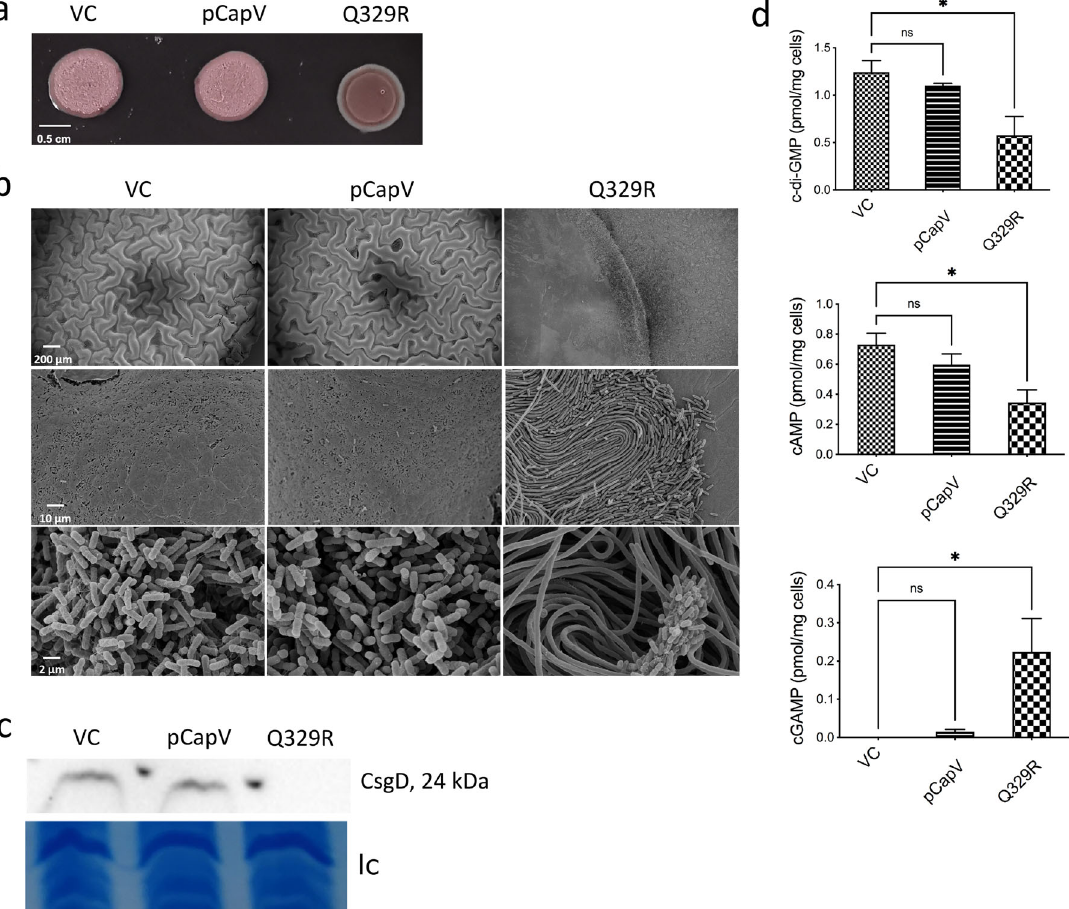
Fig. 8 CapV Q329R expression modulates rdar bio fi lm formation, CsgD expression, and cyclic (di)nucleotides levels in E. coli strain No. 12. a Rdar morphotype in wild-type E. coli No. 12 vector control (VC) and upon overexpression of CapV and its mutant CapV Q329R . Cells were grown on a salt-free LB agar plate for 24 h at 37 °C. b Scanning electron microscopy of plate-grown colonies. Colony morphotypes grown on a salt-free LB agar plate were fi xed after 24 h of growth at 37 °C. c CsgD production upon overexpression of CapV and CapV Q329R in E. coli strain No. 12 compared to VC. Only colony morphotypes from the same plate and signals from the same western blot are compared. d LC-MS/MS quanti fi cation of in vivo amounts of c-di-GMP, cAMP, and cAMP-GMP upon overexpression of CapV and CapV Q329R in E. coli strain No. 12 compared to VC. Data are displayed as absolute amounts referred to the original cell suspension. VC = pBAD28. pCapV = CapV cloned in pBAD28; Q329R = CapV Q329R cloned in